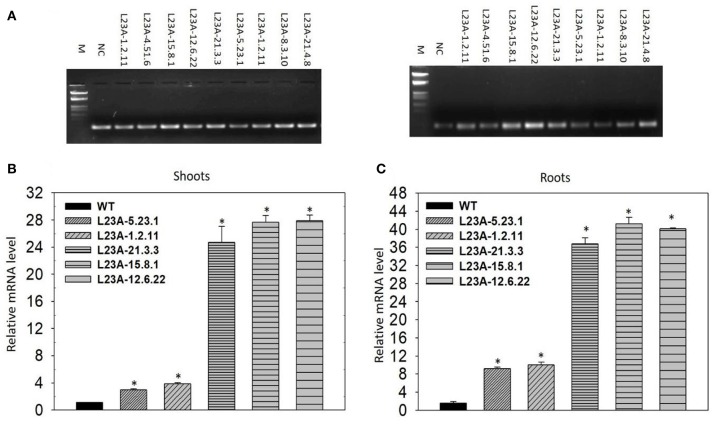
Semi-quantitative and quantitate PCR analysis of low and high expression lines. (A) (Left) Rice actin (act1) was used as an internal reference gene. (Right) RPL23A was used to assess the transcript levels to separate low and high expression levels in comparison with the Null Segregant (NS), also called Negative Control (NC). Based on the band intensity on the gel, lines L23A-15.8.1, L23A-12.6.22, and L23A-21.3.3 considered as high expression lines and the remaining lines were considered as low expression lines. The results on semi-Q were validated by qRT-PCR in (B) shoot and (C) root tissues, which also resulted in similar observations. The high expression lines exhibited >25-fold change in shoots and roots, while low expression lines had <5-fold change in both the tissues. This expression analysis was performed in the T2 generation transgenic plants. NC was used to normalize the expression pattern of RPL23A in transgenic plants. The relative expression was considered statistically significant at P < 0.05 which is represented with asterisks in the graph based on one-way ANOVA.